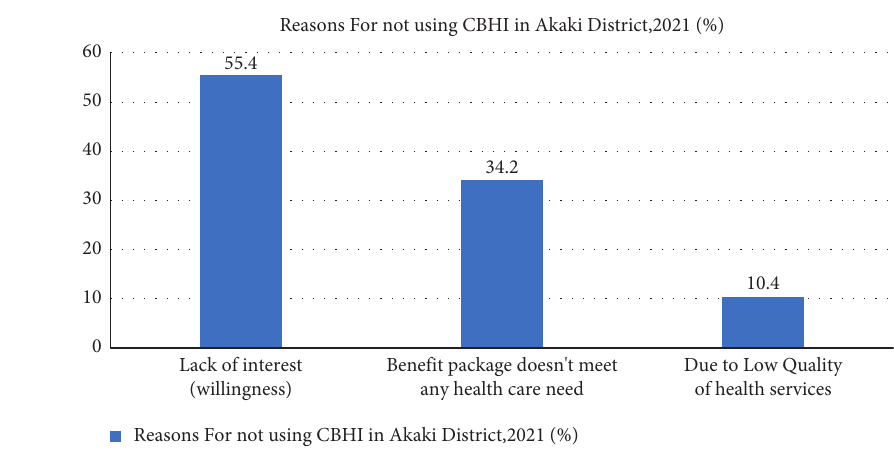
Figure 2: Reasons for not using CBHI in Akaki District,